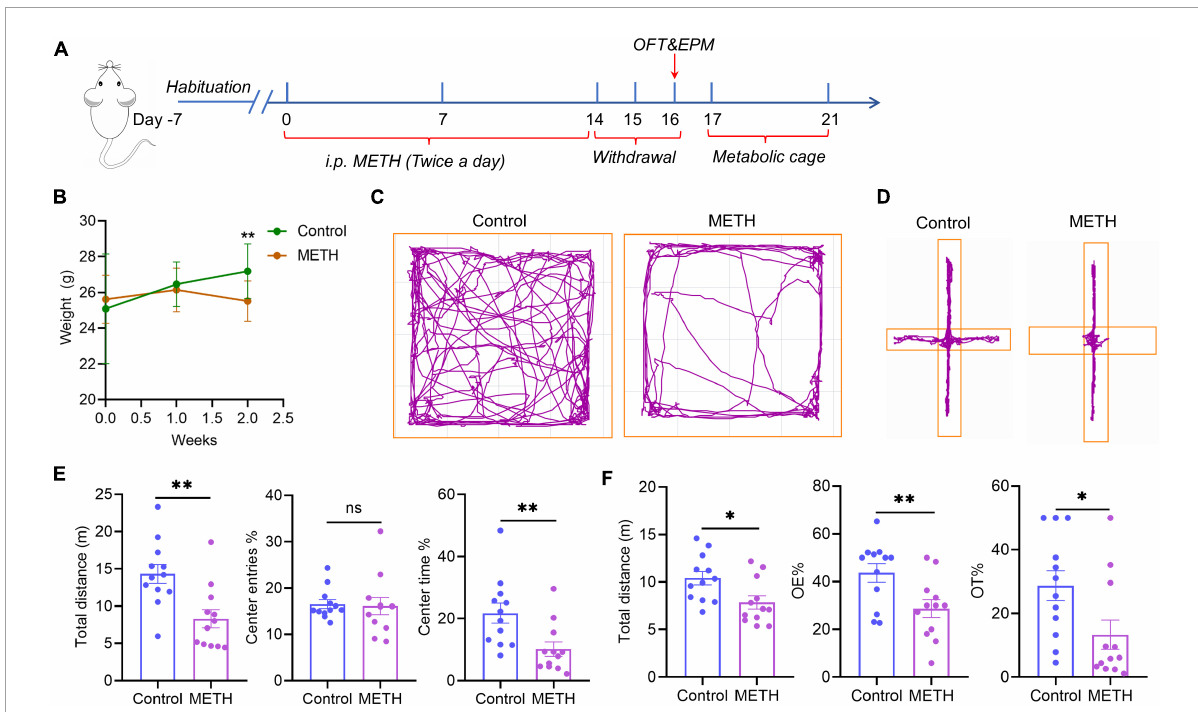
FIGURE1 Acute METH withdrawal–induced anxiety-like symptoms. (A) The timeline of the mouse model of anxiety-like symptoms induced by METH acute withdrawal. (B) The weight changes that occurred in mice during 2 weeks of METH exposure. (C) The behavioral trajectories of mice in the METH group and control group in the open field test. (D) The behavioral trajectories of mice in the METH group and control group in the elevated plus maze experiment. (E) The behavioral experiment results of the OFT test in the METH group ( n = 12) and control group ( n = 12). (F) The behavioral experiment results of the EPM test in the METH group ( n = 12) and control group ( n = 12). The data were compared with an unpaired t -test and are expressed as the mean ± SEM. Significance is shown as * p < 0.05, ** p < 0.01, *** p < 0.001, and **** p <